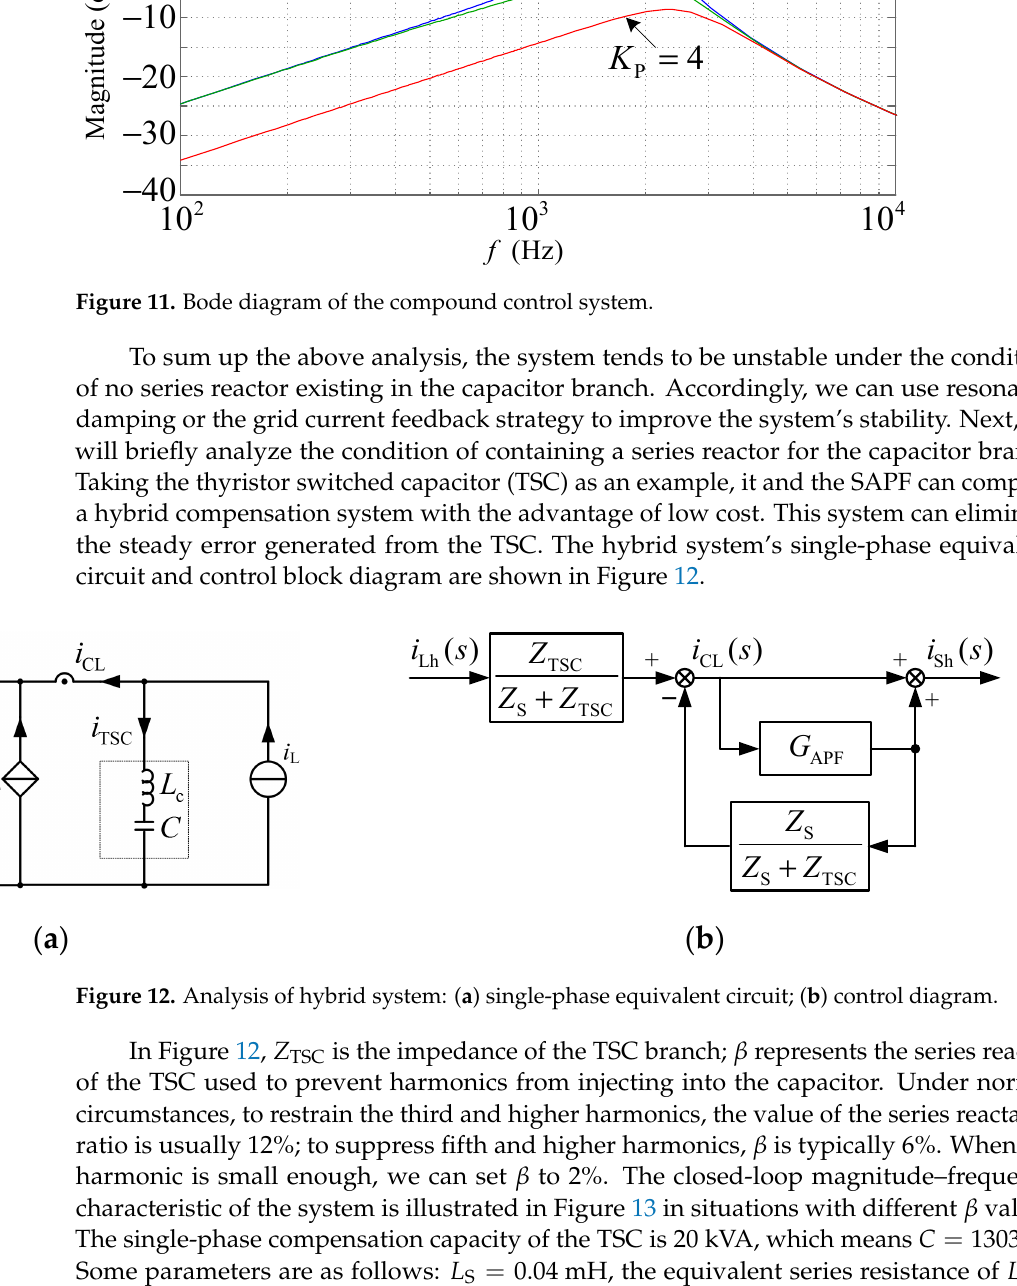
Figure 12. Analysis of hybrid system: ( a ) single-phase equivalent circuit; ( b ) control diagram.